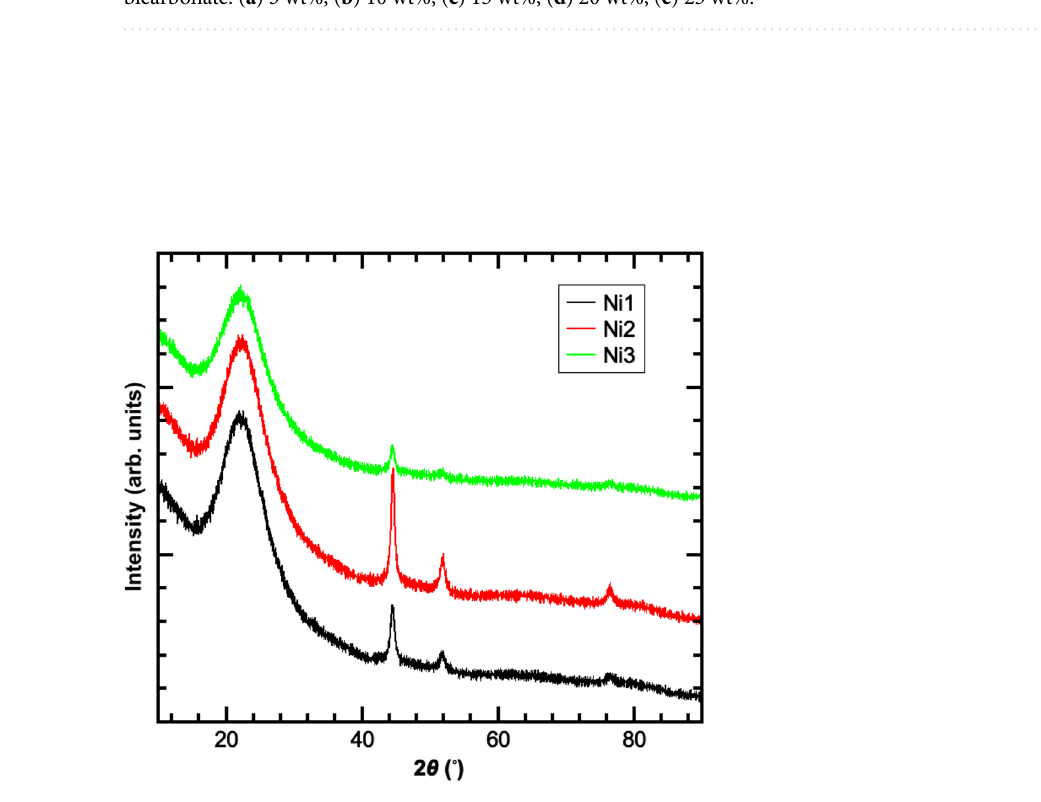
Figure 4. SEM images of undoped silica aerogels synthesized with different concentrations of ammonium bicarbonate: ( a ) 3 wt%, ( b ) 10 wt%, ( c ) 15 wt%, ( d ) 20 wt%, ( e ) 25 wt%.